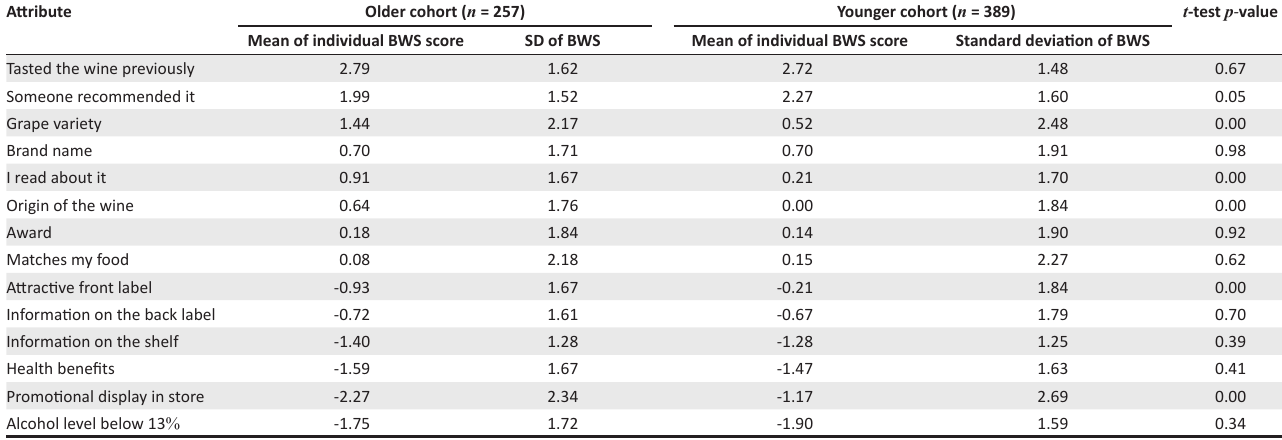
TABLE 3: Summary of the best–worst scaling scores of wine attributes for the two age cohorts. Attribute